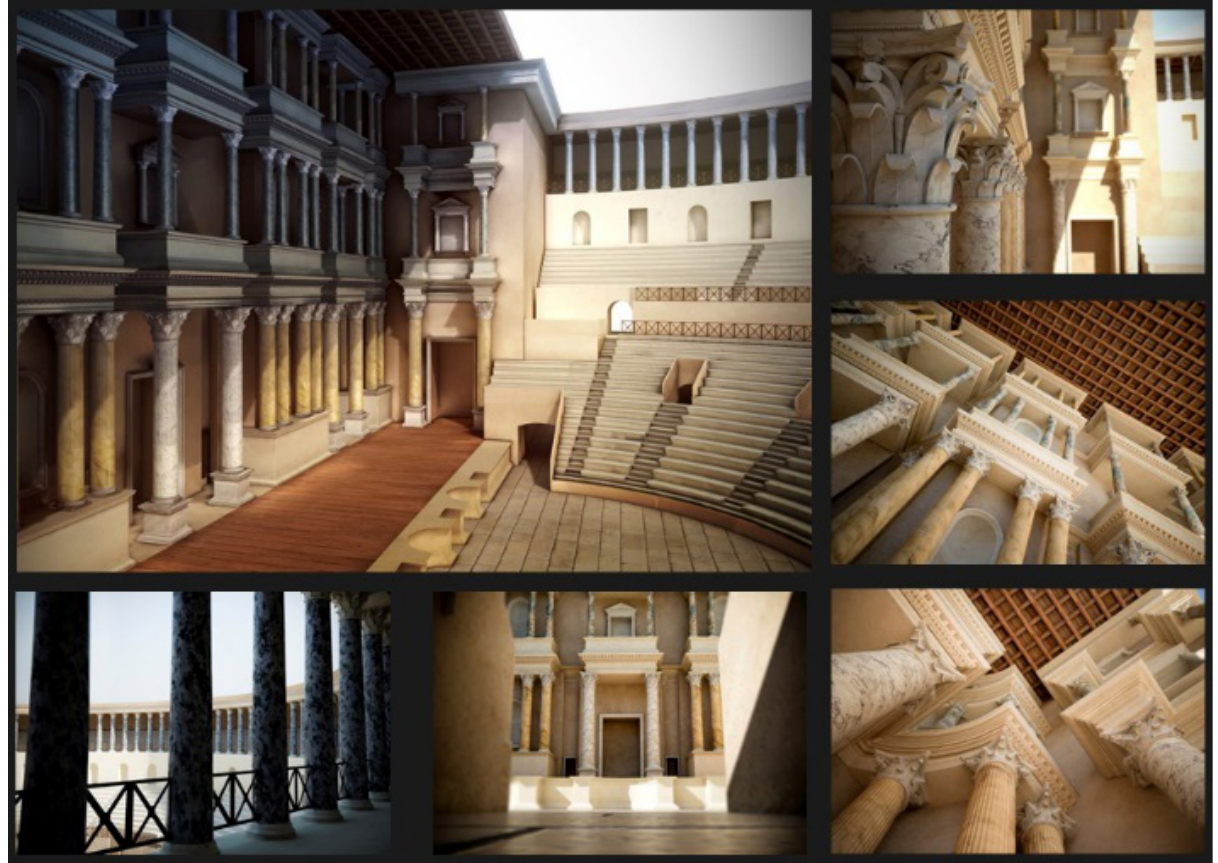
Figur e 13: Views of the reconstruction carried out in AR. The advanced shaders allow to obtain very realistic light effects. The procedural variance parameters make each element different from the other similar instances, avoiding the need to model new